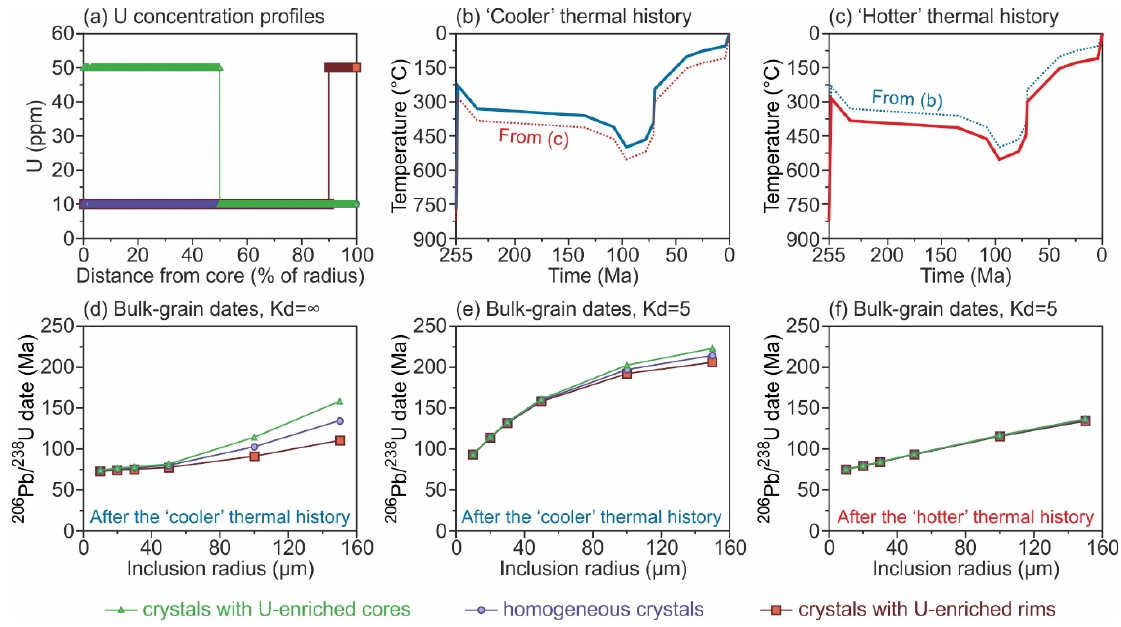
Figure 5. A comparison of synthetic bulk-grain 206 Pb/ 238 U dates of chemically zoned apatite crystals with either open or flux limited boundaries. ( a ) Modelled core to rim U concentration profiles. ( b , c ) Modelled “cooler” and “hotter” thermal histories, respectively. ( d ) 206 Pb/ 238 U dates obtained from apatite crystals with open boundaries that experienced the “cooler” thermal history (the first group). ( e , f ) 206 Pb/ 238 U dates of alkali feldspar-hosted apatite inclusions that followed the “cooler” and “hotter” thermal histories, respectively (the second and third groups, respectively).